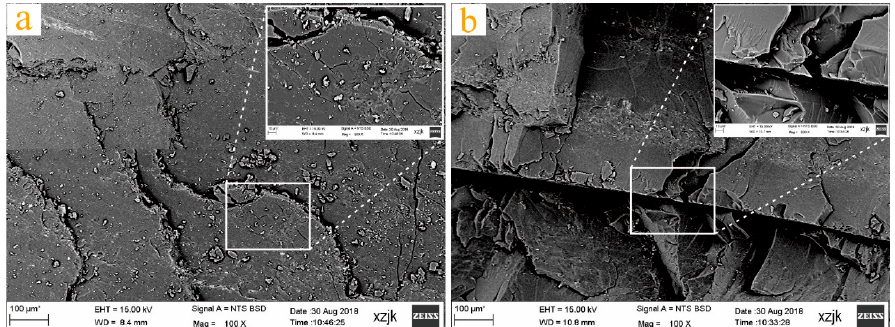
Figure 2. Microscopic position of coal: ( a ) smooth position; ( b ) fracture position.